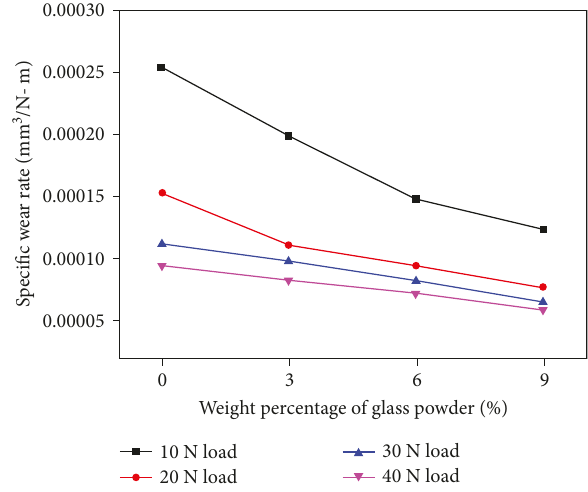
Figure 10: Variation of specific wear rate with the reinforcement contained at the different applied load conditions.